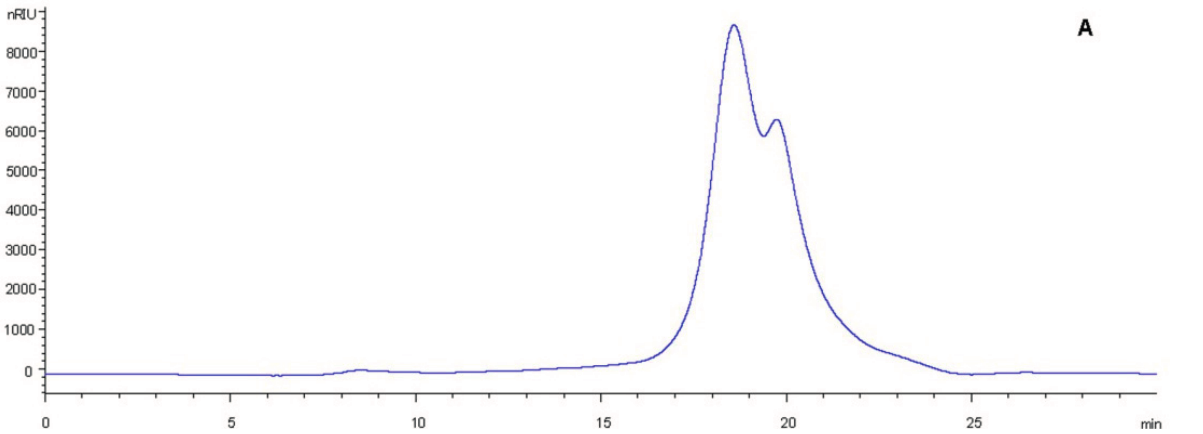
Figure 2. High performance gel permeation chromatography (HPGPC) chromatogram of MPP on TSKgel G3000 PW XL column (Tosoh Corporation, Yamaguchi, Japan) ( A ); Reversed-phase high performance liquid chromatography (HPLC) analysis of monosaccharide composition in MPP. The standards were separated under the conditions described in ( B ); and the derivatives of MPP hydrolysate were separated described in ( C ) (Man, mannose; GlcN, glucosamine; GlcA, glucuronic acid; Rha, rhamnose; GalA, galacturonic acid; Glc, glucose; Gal, galactose; Xyl, xylose; Arab, arabinose; Fuc,